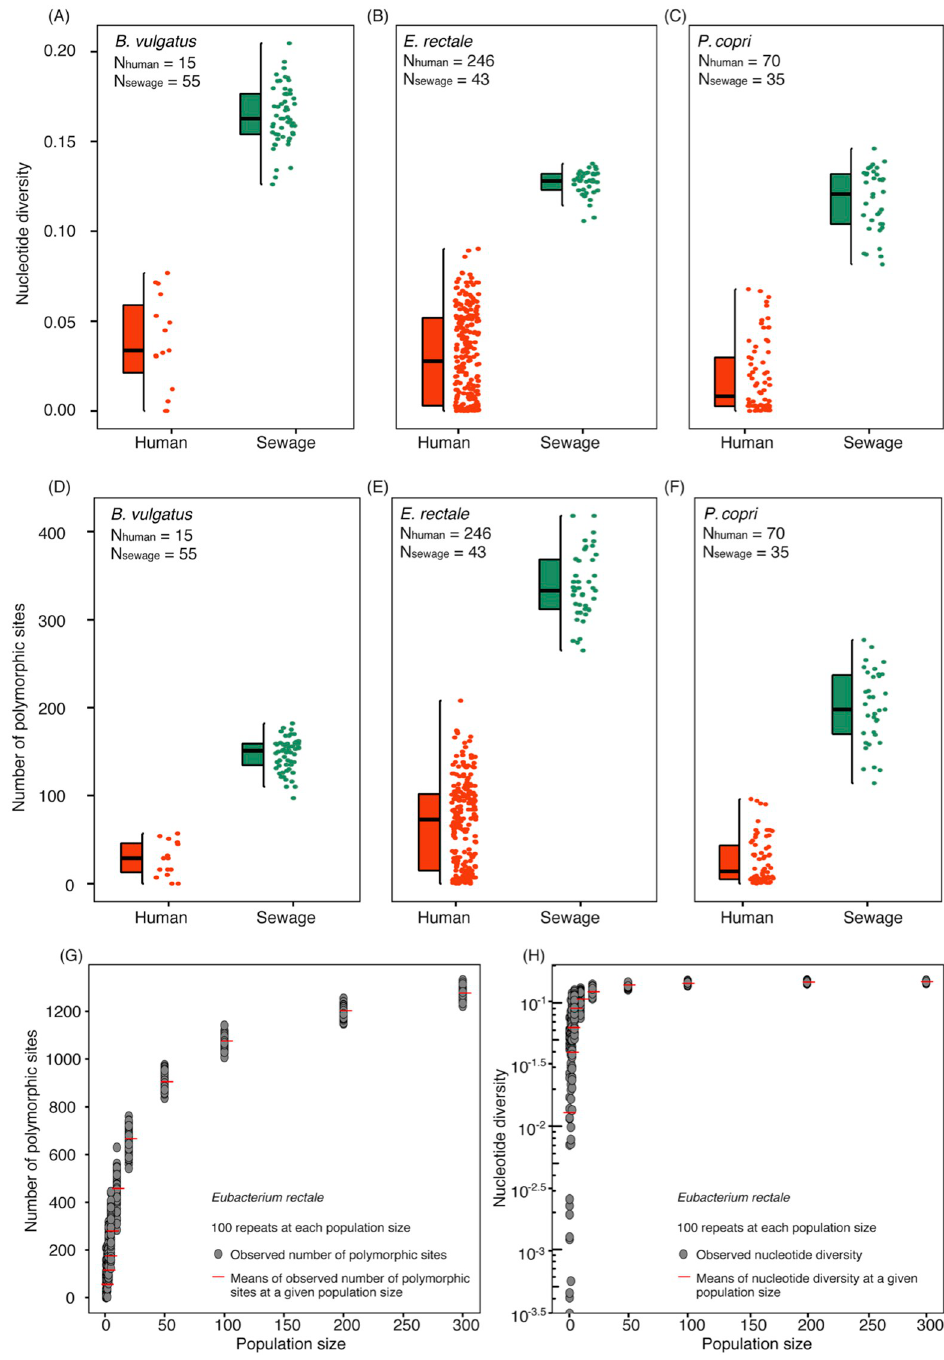
Fig 4. Sub-species diversity in gut-associated bacterial species as a potential marker for human population size. (A-F) Comparison of sub-species diversity of gut-associated bacteria in human gut microbiome samples (LifelinesDeep) and MIT sewage samples. Nucleotide diversity and numbers of polymorphic sites were computed from ten phylogenetic marker genes. (G) and (H) Simulation results showing intra-species diversity in response to increasing population size, as represented by the number of polymorphic sites (G) and nucleotide diversity (H).